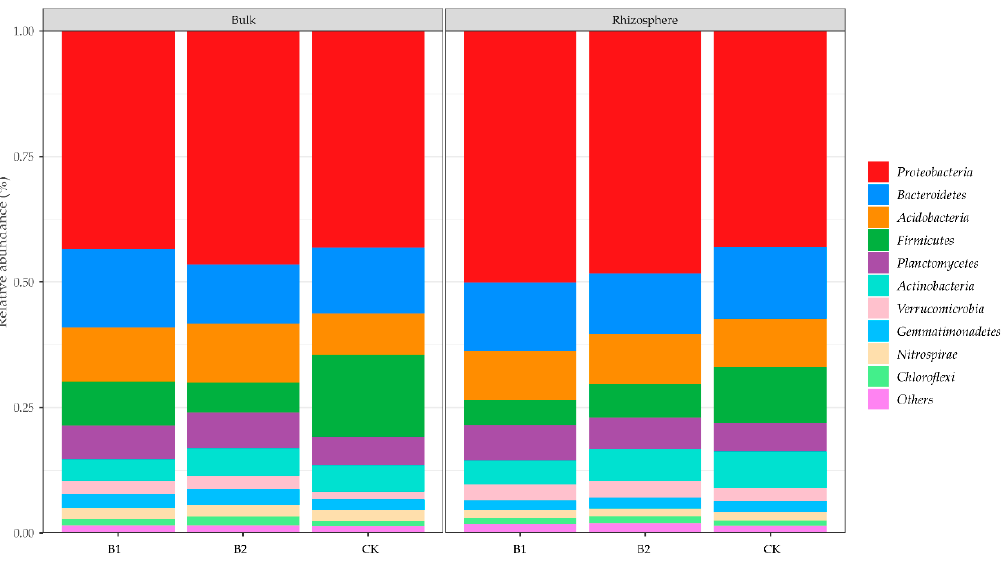
Figure 6. Relative abundance of different phyla in rhizosphere and bulk soils of maize following biochar application. Treatment abbreviations (CK, B1, and B2) are defined in Figure 2 caption.